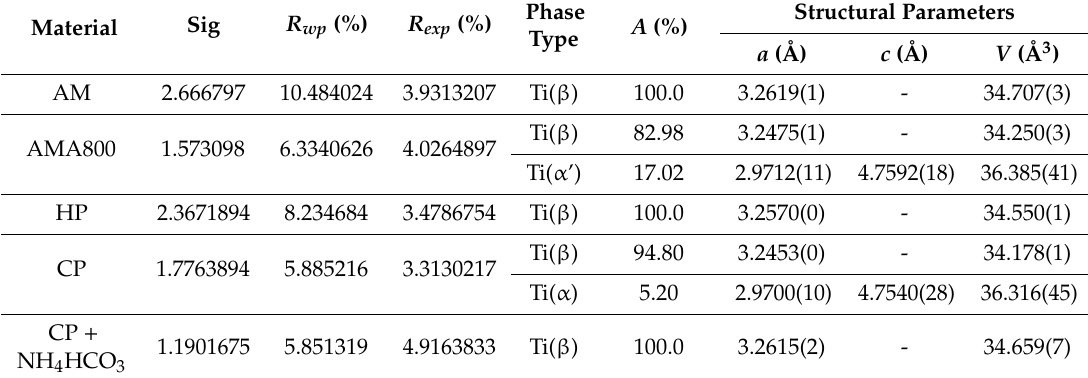
Table 1. The structural parameters of Ti23Mo alloys synthesized by different processing approaches, estimation based on the Rietveld approach with phase amounts values ( A %).